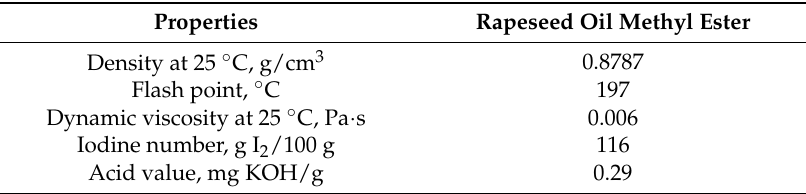
Table 1. Physicochemical properties of rapeseed oil methyl ester.